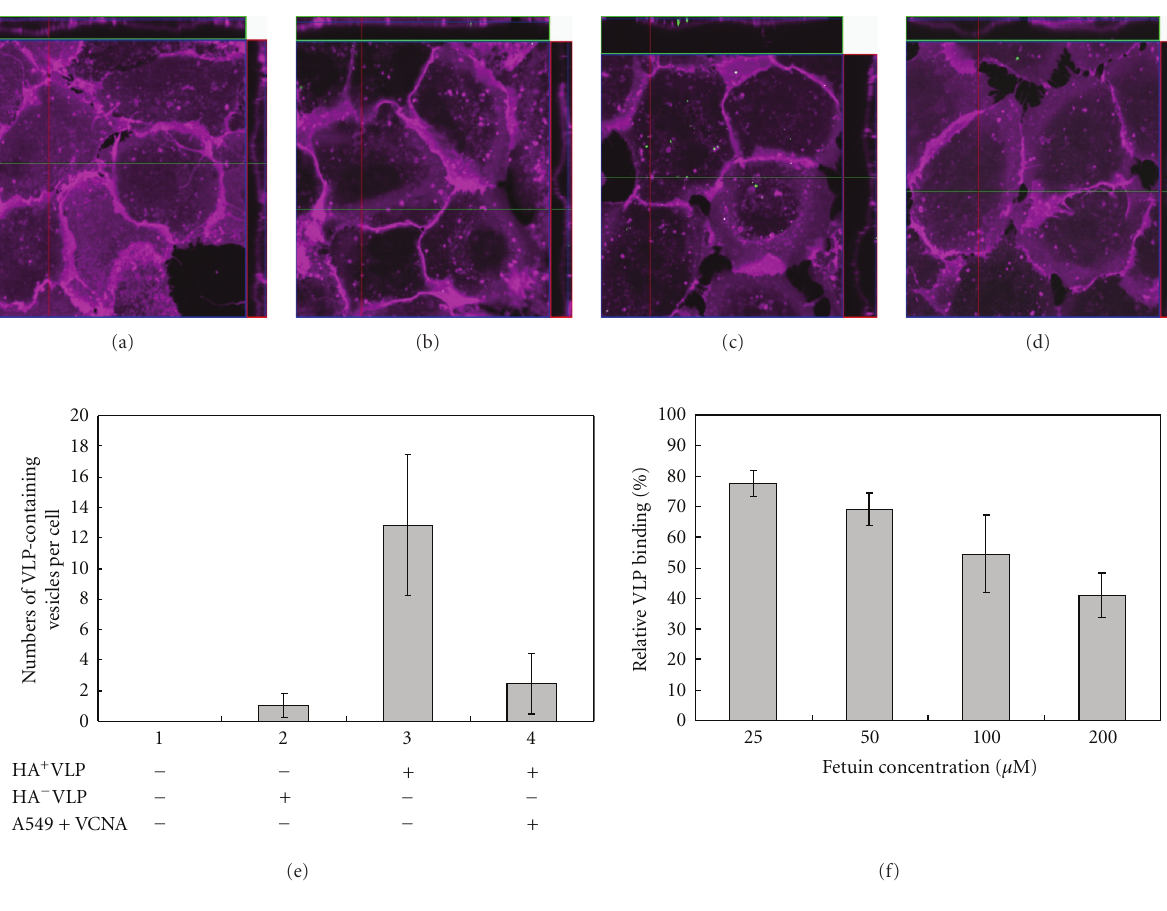
Figure 3: HA-mediated endocytosis of VLP in A549 cells. A549 cells were added to VLPs labeled with DiO dye and incubated on ice for 1h. The unbound VLPs were washed away, and the cells were incubated at 37 ◦ C for further 2h. (b) and (c) show A549 cells incubated with HA − VLPs or HA + VLPs, respectively. (d) displays VCNA-pretreated A549 admixed HA + VLP. (a) is a mock control. The upper and right rectangular images of each panel depict horizontal and vertical cross-sections located at green and red lines, respectively. VLPs were labeled with DiO dye (green), and A549 cells were stained with DiD dye (pink). Graph in (e) represents the average of endocytosed VLPs per cell. Graph in (f) depicts the inhibitory e ff ect of fetuin on VLP binding. The values of relative VLP binding was determined by the ratio of R18 signals at each concentration of fetuin to the value obtained for the maximum binding of VLPs without the fetuin treatment.